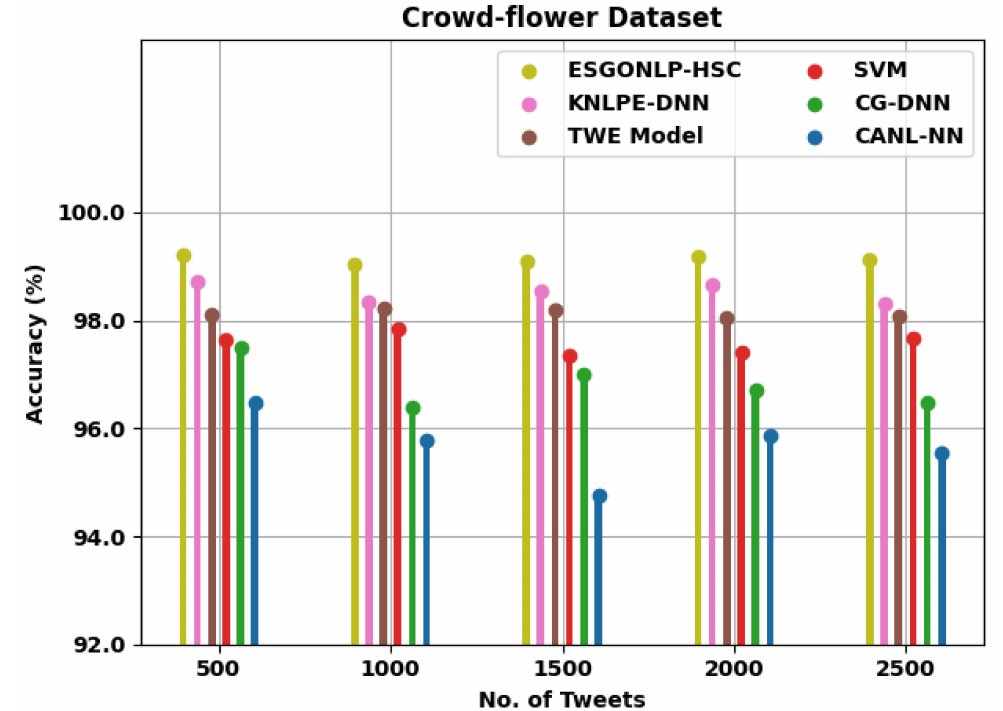
Figure 4. Accu y analysis of ESGONLP-HSC technique under Crowd-flower dataset.